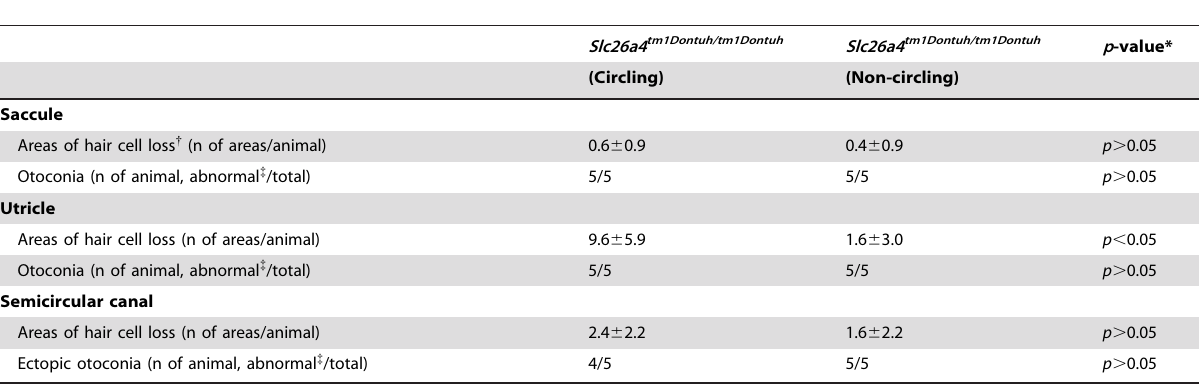
Table 2. Comparison of vestibular morphological findings according to the vestibular phenotype of